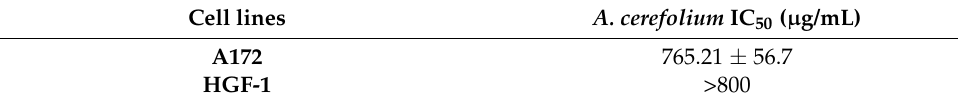
Table 2. Cytotoxic activity of A. cerefolium methanolic extract on A172 and HGF-1 cells. Cell